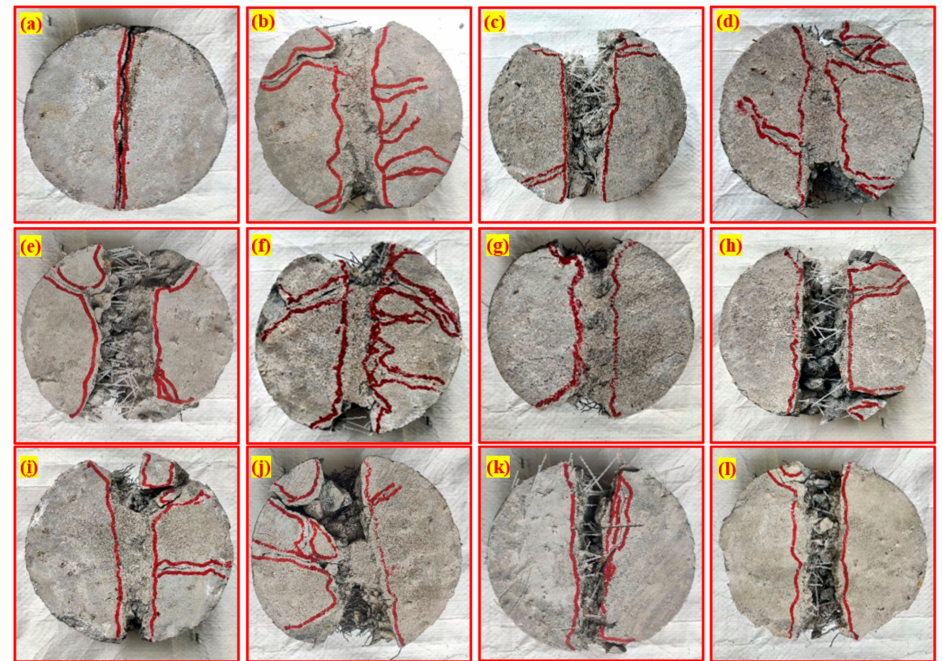
Figure 13. Failure pattern of specimens ( a ) PAC, ( b ) S-SF, ( c ) S-PF, ( d ) D-SF-PF, ( e ) D-PF-SF, ( f ) T-FG1, ( g ) T-FG2, ( h ) T-FG3, ( i ) T-FG4, ( j ) T-FG5, ( k ) T-FG6, ( l )